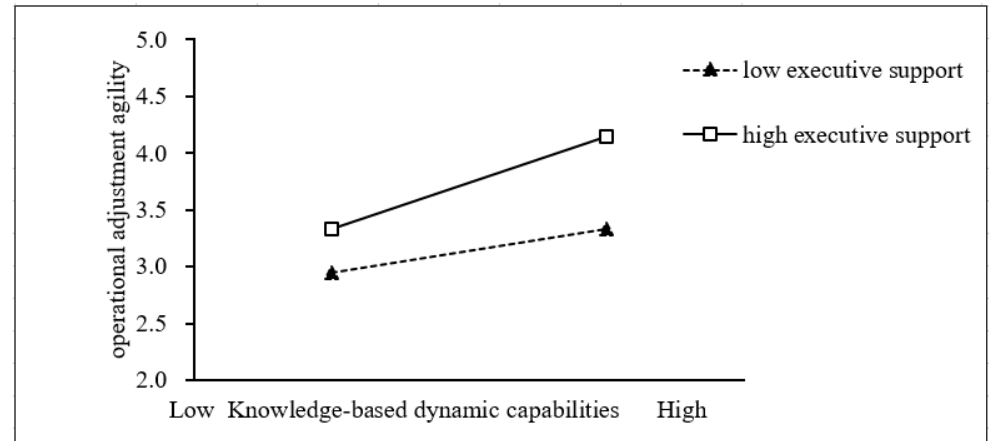
Figure 4. Knowledge-based dynamic capabilities and executive support interact to influence oper- ational adjustment agility.